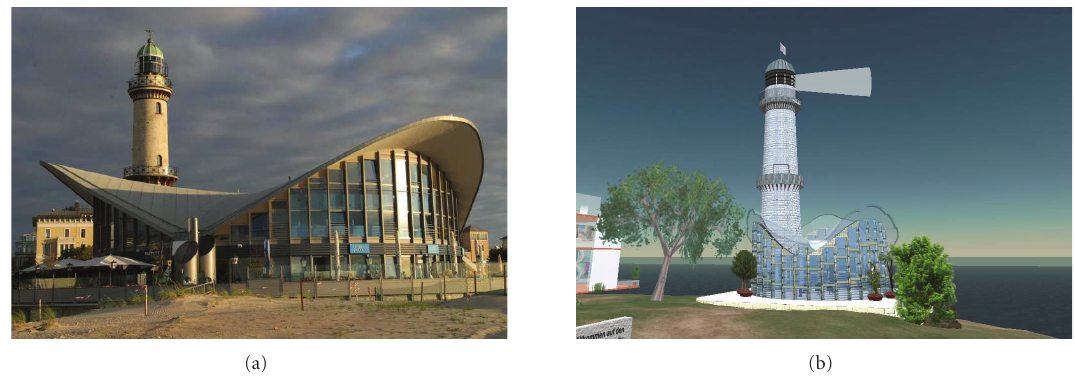
Figure 2: The lighthouse and “Teepott” have been transferred from real-life (as a nautical and touristical landmark) to our virtual site in Second Life (as a learning and communication